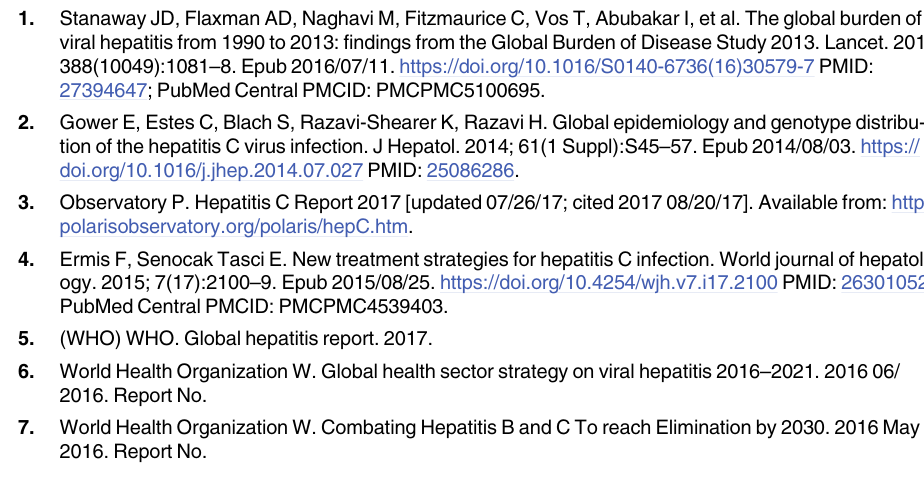
S1 Fig. Schematic of the HCV natural history and treatment model disease stages (boxes) and transitions (arrows). F0, F1, F2, F3, F4 denote METAVIR stages. SVR: sustained viral response. DC: decompensated cirrhosis. HCC: hepatocellular carcinoma. We assume no liver transplant and individuals diagnosed with DC/HCC are not treated for HCV. Individuals who failed treatment are not